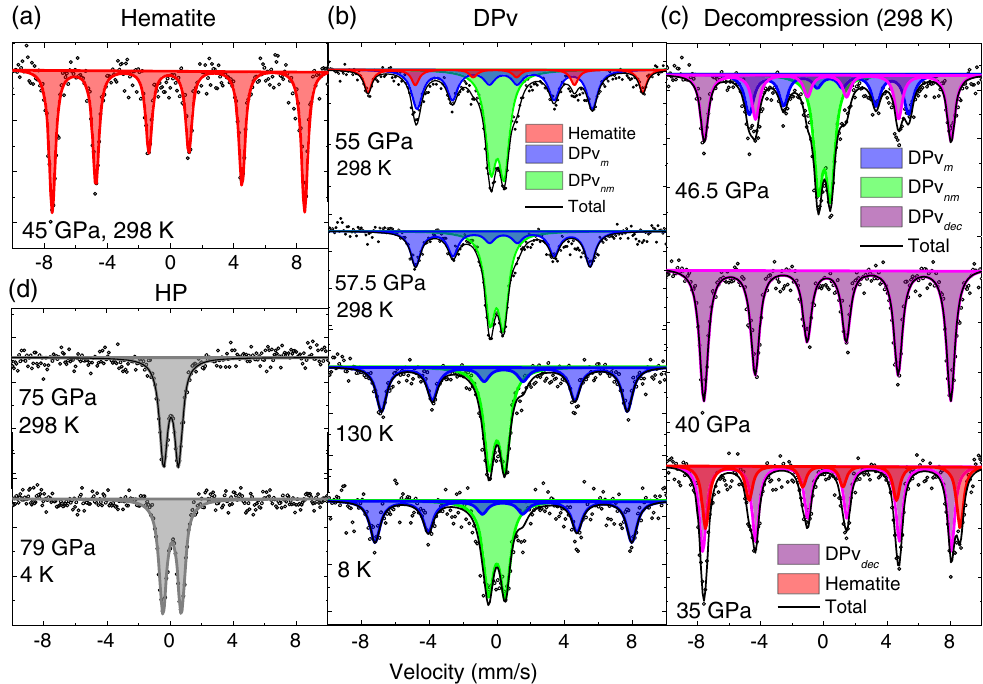
FIG. 6. 57 Fe Mössbauer spectra of Fe 2 O 3 at various pressures and temperatures: at room temperature (a),(c) and reduced temperatures (b),(d), upon compression (a),(b),(d) and decompression (c). Red, blue, green, and magenta lines and shaded areas represent fits to the hematite, magnetic DPv (DPv m ), nonmagnetic DPv (DPv nm ), and DPv components; the black solid line is the sum of all components. dec The high-pressure phase (HP) component is shown in solid